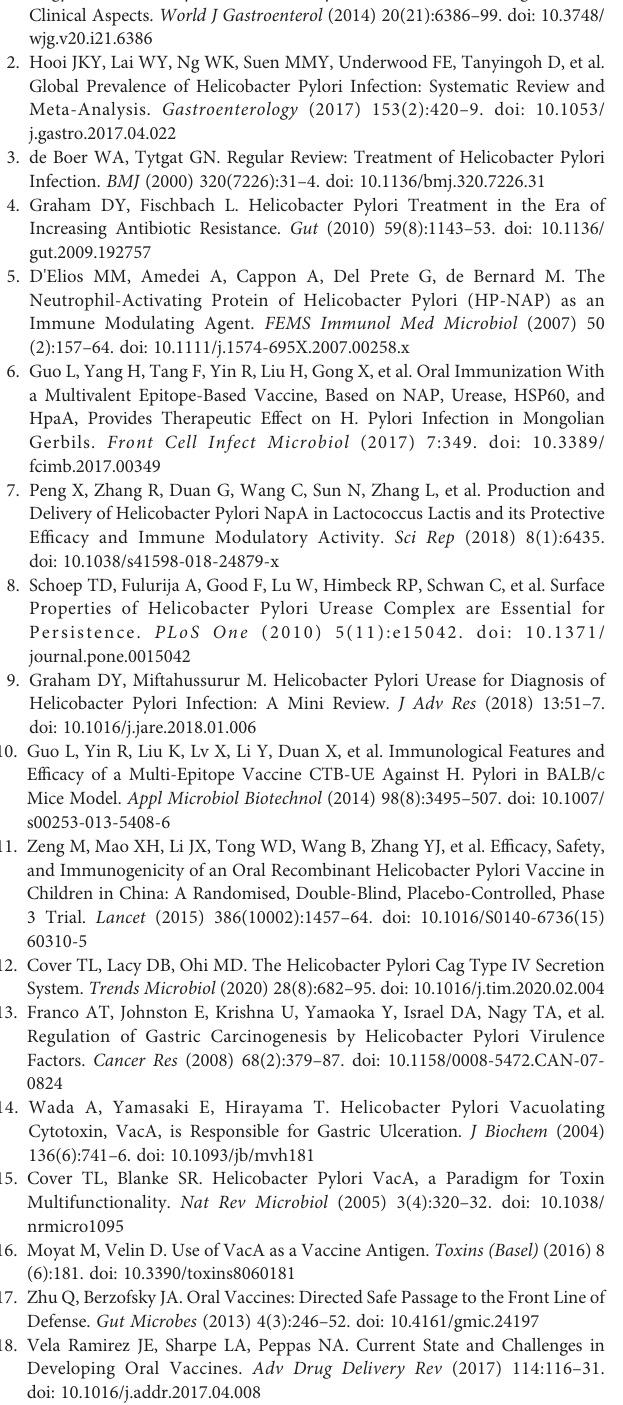
Supplementary Figure 1 | Construction and identi fi cation of the plSAM plasmid. (A) Construction of the plasmid plSAM. (B) Identi fi cation of the plasmid plSAM. 1: the plasmid plSAM. 2: plSAM digested by Nco I and Hind III. M: DNA marker.